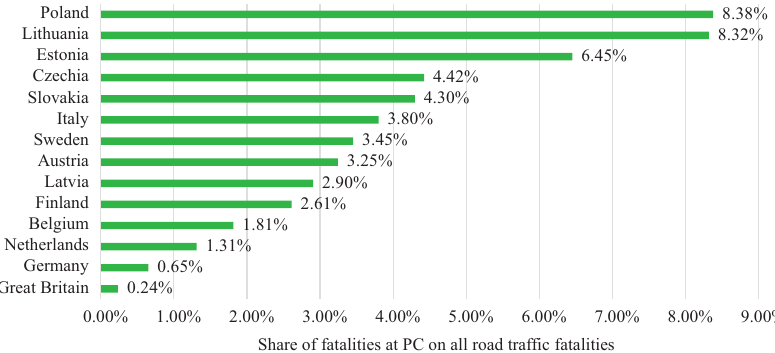
Figure 3. Number of people killed at PCs expressed as a percentage of all road-related